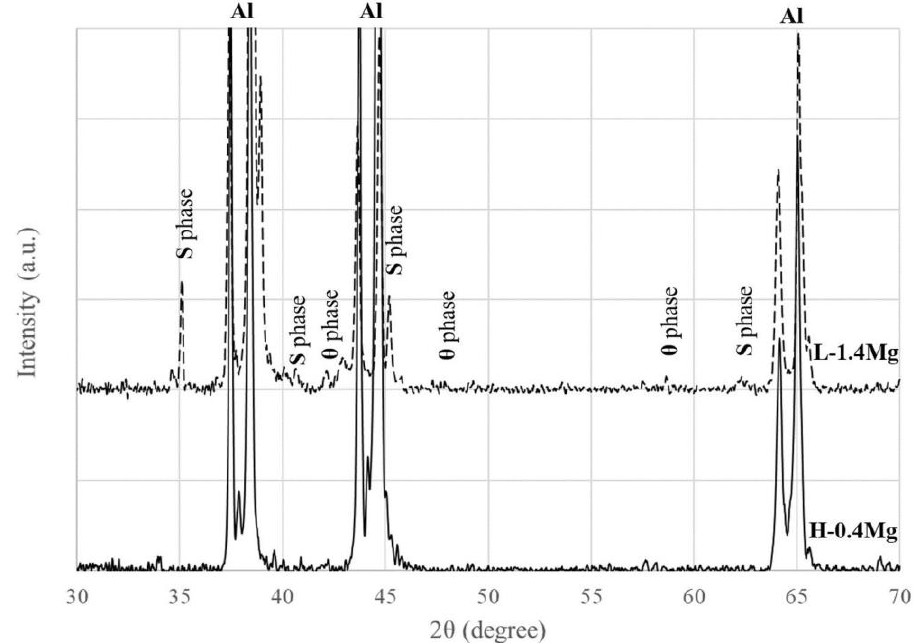
Figure 5. X-ray diffraction (XRD) patterns of H-0.4Mg and L-1.4Mg alloys at peak-aged state. Figure 5. X-ray di ff raction (XRD) patterns of H-0.4Mg and L-1.4Mg alloys at peak-aged